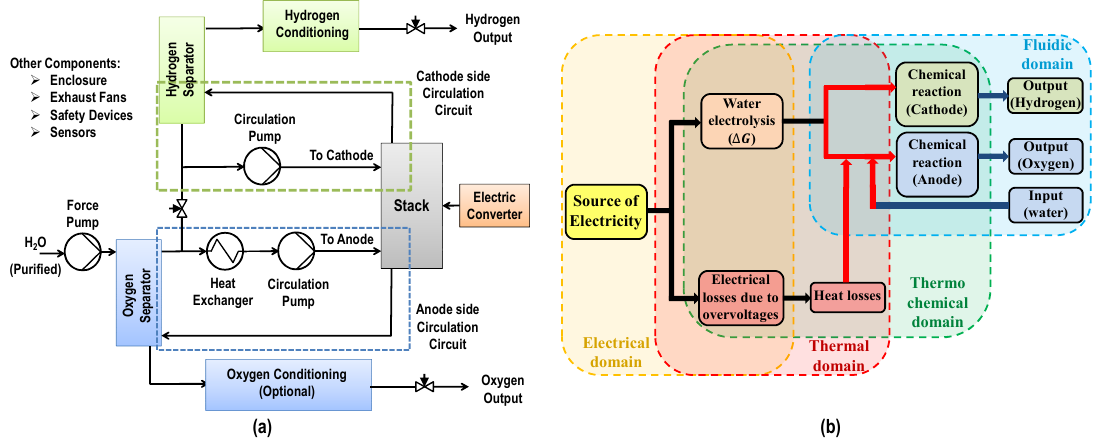
Figure 2. ( a ) General schematic of a Proton Exchange Membrane (PEM) electrolyser and ( b ) Multi-physics phenomena in PEM electrolyser cell/stack (inspired by Reference